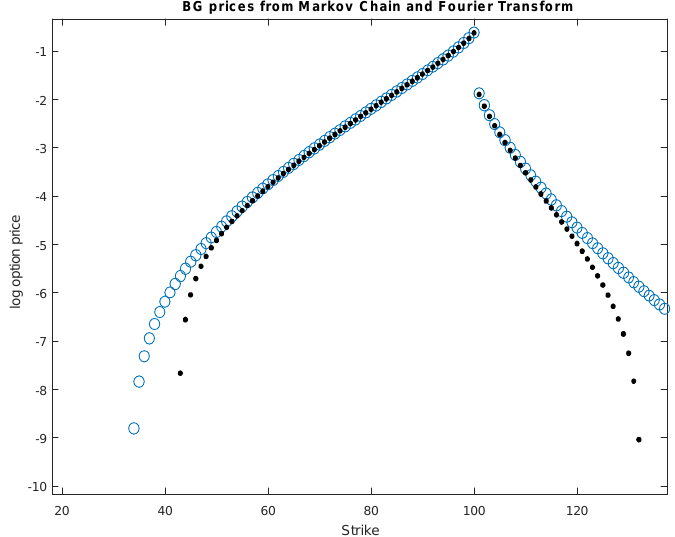
Figure 2. Out of the money log option prices as functions of strike at the maturity 0.04 for bilateral gamma parameters 0.0906, 0.5183, 0.3501, 0.4805 for b p , c p , b n , and c n respectively. The Markov chain Figure 2: Out of the money log option prices as functions of strike at the approach is shown in circles while the Fourier transform approach is presented by maturity 0.04 for bilateral gamma parameters .0906, .5183, .3501, .4805 for b c ; b ; and c respectively. The Markov chain approach is shown in circles while p n n the Fourier transform approach is presented by dots.